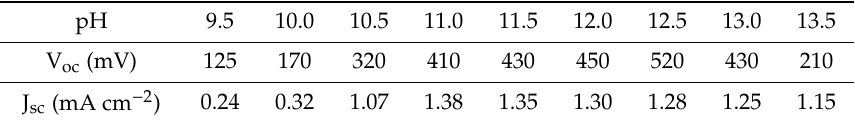
Table 1. Photovoltaic properties of the cuprous oxide (Cu 2 O) homojunction solar cell with di ff erent bath pH of the p -Cu 2 O deposition.